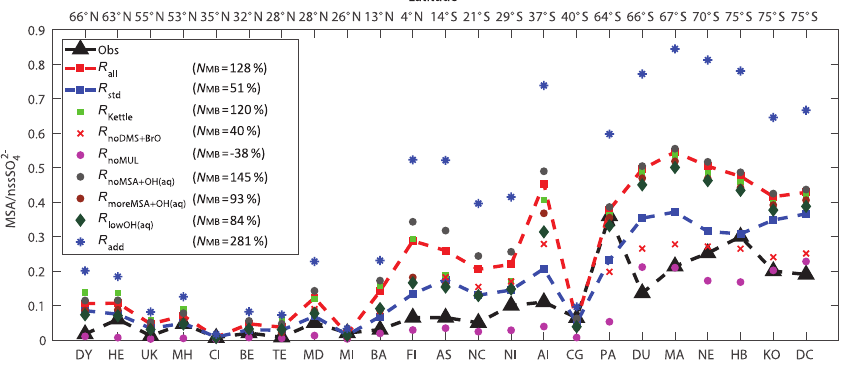
Figure 10. Comparison between modeled (nine model runs described in Table 3) and observed (obs, black triangle) annual-mean surface MSA / nssSO 2 − ratios at 23 stations around the globe. The normalized mean bias N MB = 4 modeled value and observed value, respectively, is shown in inset.